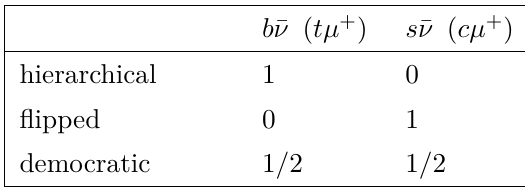
Table 2 . Branching fractions of the V − 1 / 3 section